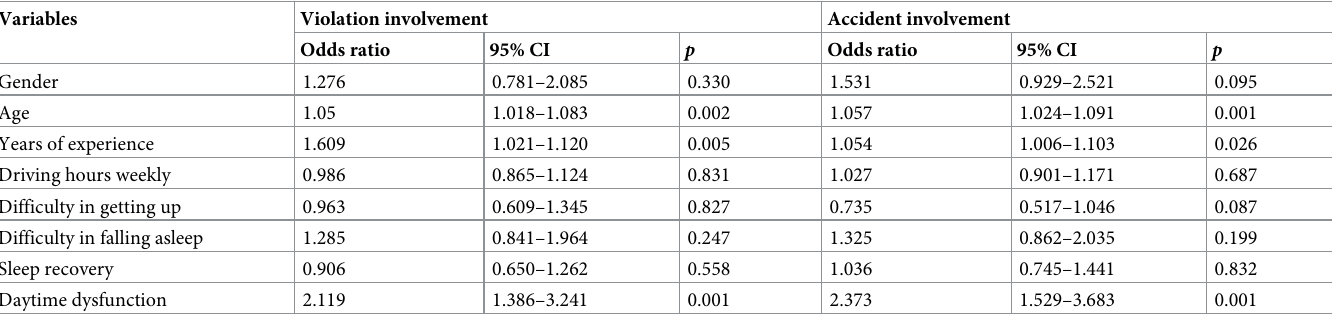
Table 6. Predictive role of the SQS-C factors on violation and accident